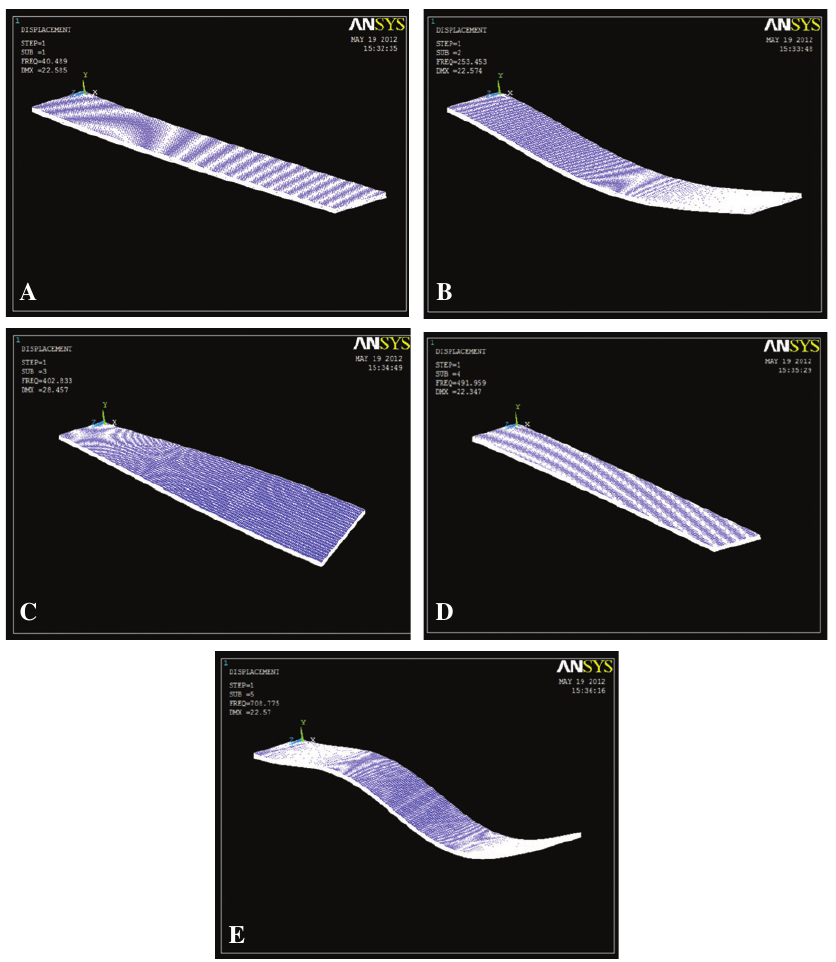
Figure 11 Mode shapes of composite beam (w-c). (A) Mode 1, (B) mode 2, (C) mode 3, (D) mode 4, (E) mode